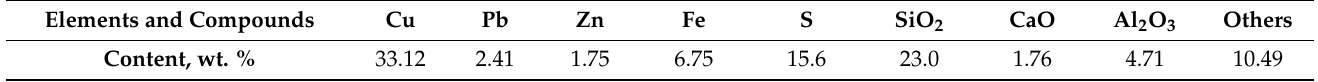
Table 6. Composition of copper